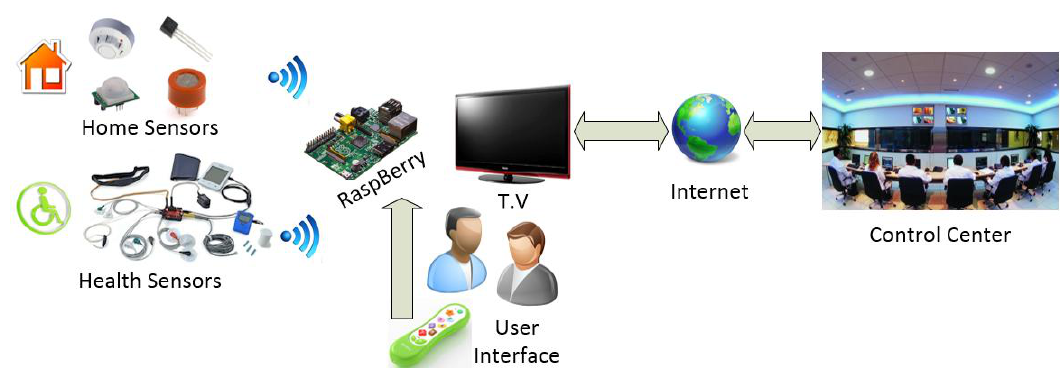
Figure 8. Interaction system based on